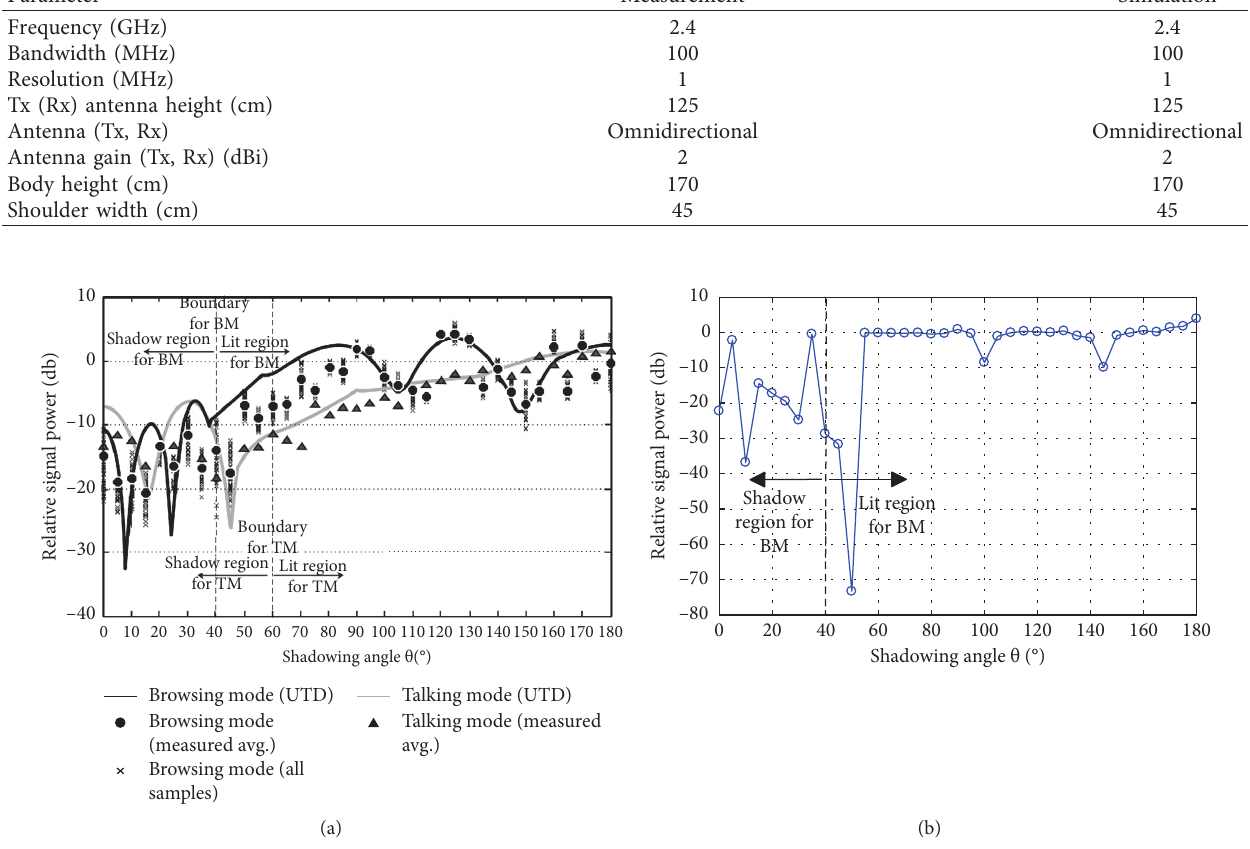
Figure 19: Verification scenario I. (a) Measurement results [26]. (b) Simulation results of browsing mode